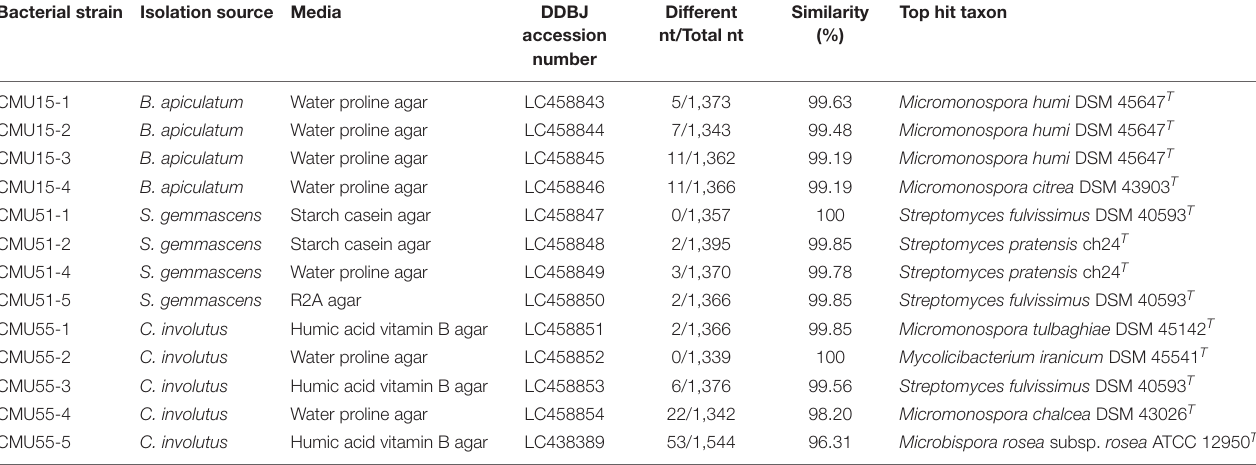
Bacterial strain Isolation source